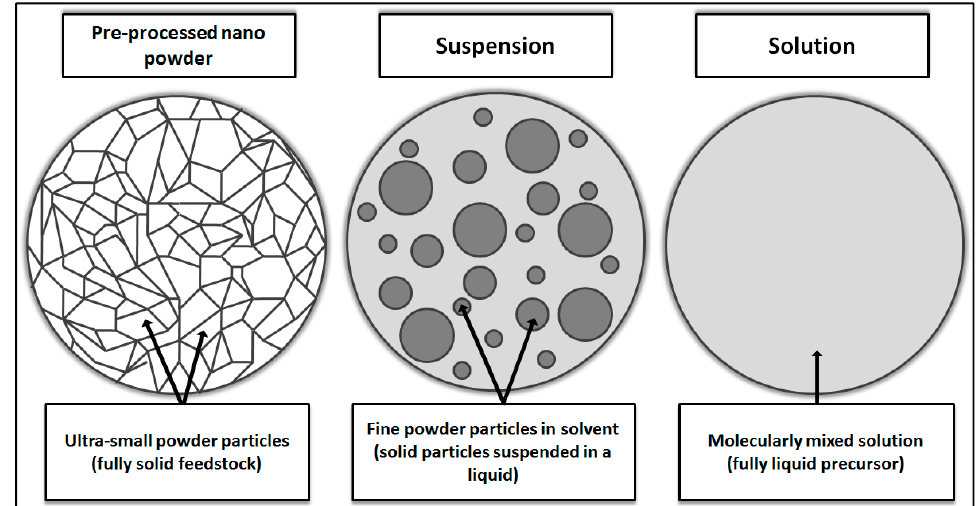
Figure 12. The feedstock used for deposition of finely-grained coatings by thermal spraying [27]. Reproduced with permission from [Advances in Materials Science Research], Nova, 2016.